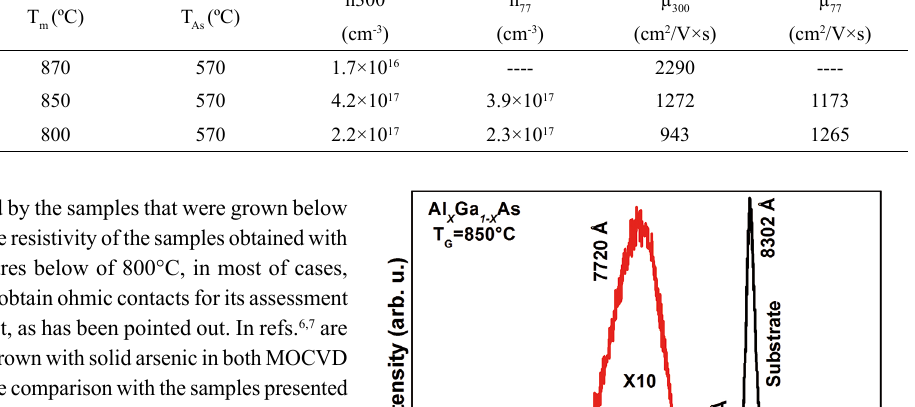
Table 1: Electric measurements obtained by Hall Effect of Al the thermodynamic parameters. Sample